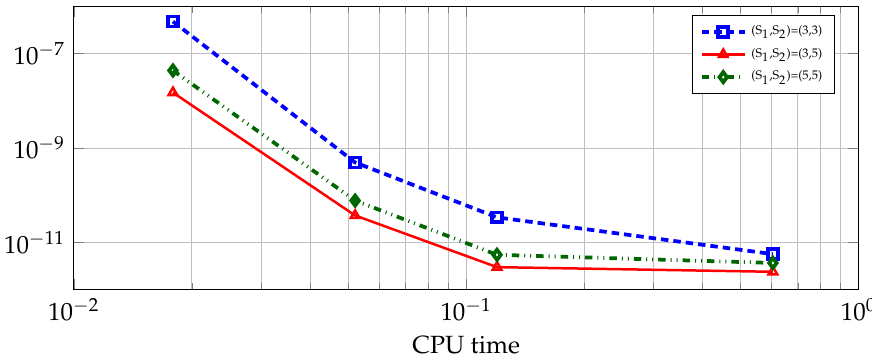
Figure 3. Position error for the modified satellite solar system an arbitrary taken time t = 1 for the exponential integrators for S 1 = 3, S 2 = 5 (red line), S 1 = 5, S 2 = 5 (green line) and the ones that use S 1 = S 2 = 3 (blue